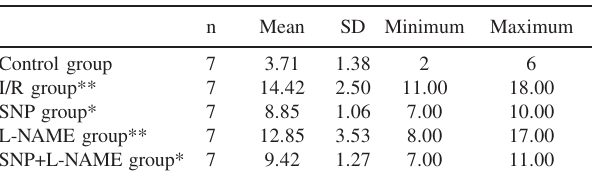
Table 2 - Tissue Malonyl dialdehyde levels of the groups (nmol/gr tissue). n Mean SD Minimum Maximum Control group 7